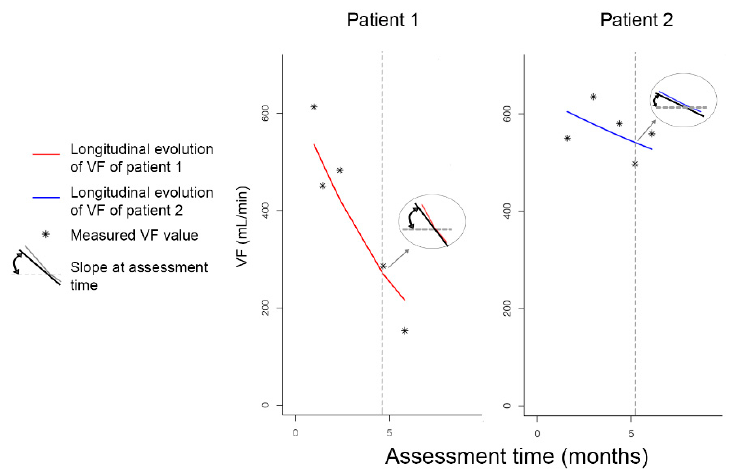
Figure 1. Illustration of a longitudinal evolution of patient 1, who eventually developed a stenosis or occlusion, and patient 2, who remained lesion-free. The figure illustrates the different parametrizations that can be assessed; that is, the DUS values and their pattern over time (i.e., the slope) of the values at assessment time.